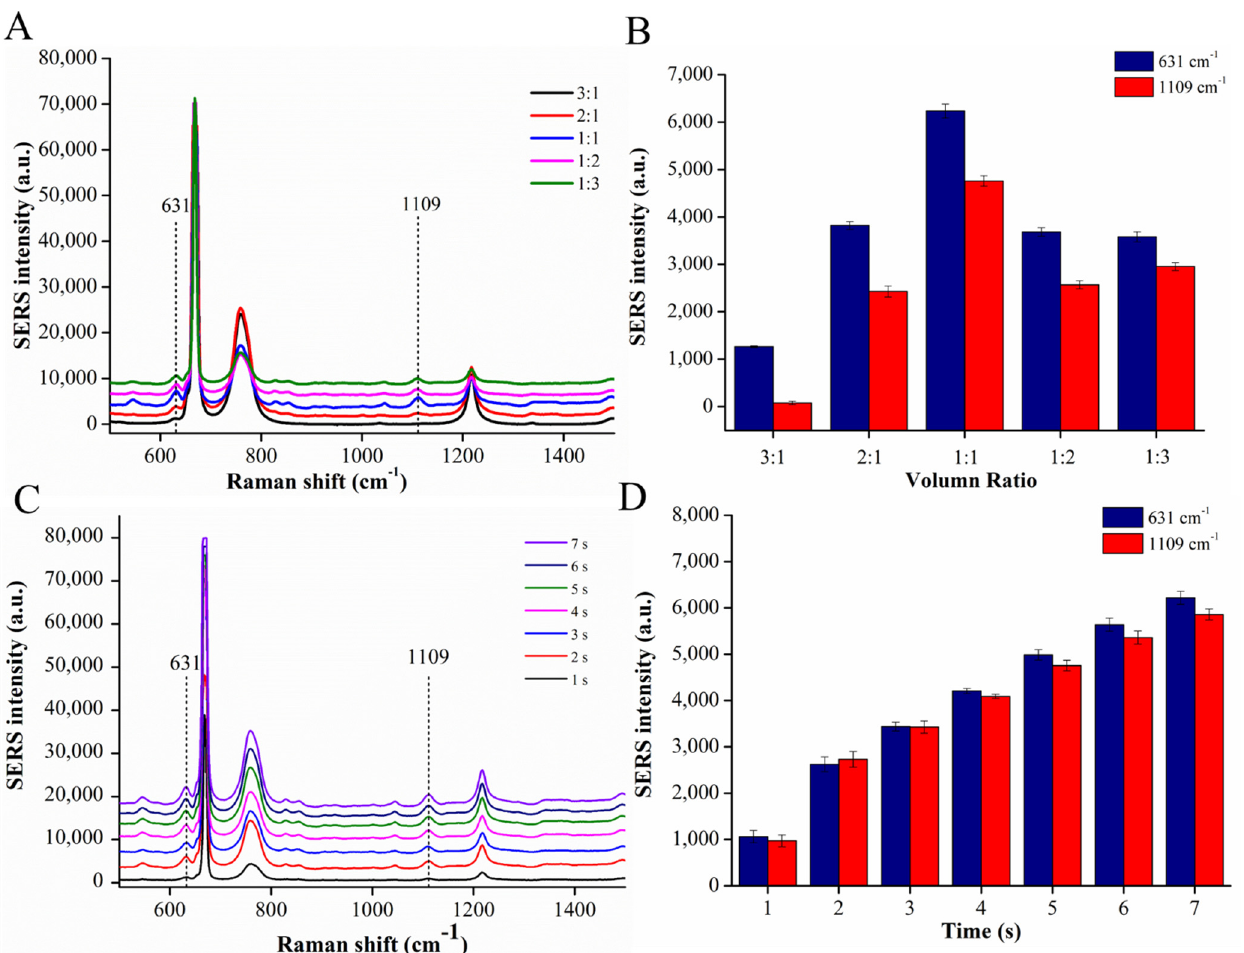
Figure 4. ( A ) SERS spectra of acetamiprid collected with the Au NP array generated by chloroform and Au NPs at volume ratios from 3:1 to 1:3; ( B ) SERS intensity of 631 cm − 1 and 1109 cm − 1 at different volume ratios; ( C ) SERS spectra of acetamiprid collected with an integration time of 1 s to 7 s; ( D ) SERS intensity of 631 cm − 1 and 1109 cm − 1 at different integration times.